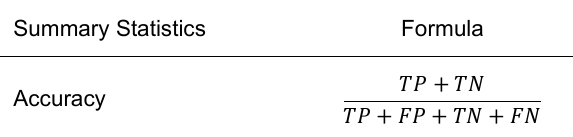
Table 3. Performance Evaluation Statistics Summary Statistics